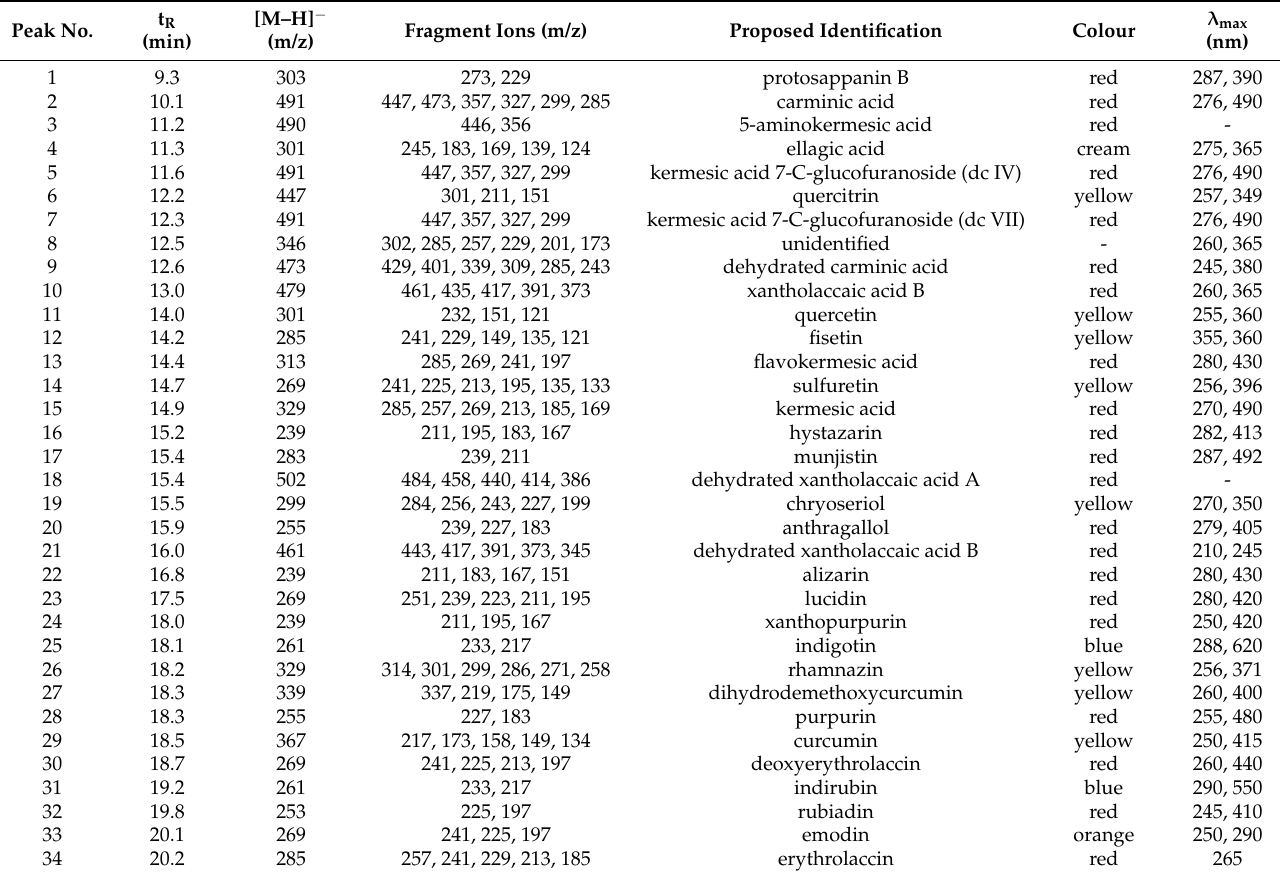
Table 4. Spectrochromatographic data of the dyes extracted from the investigated textiles. Peak